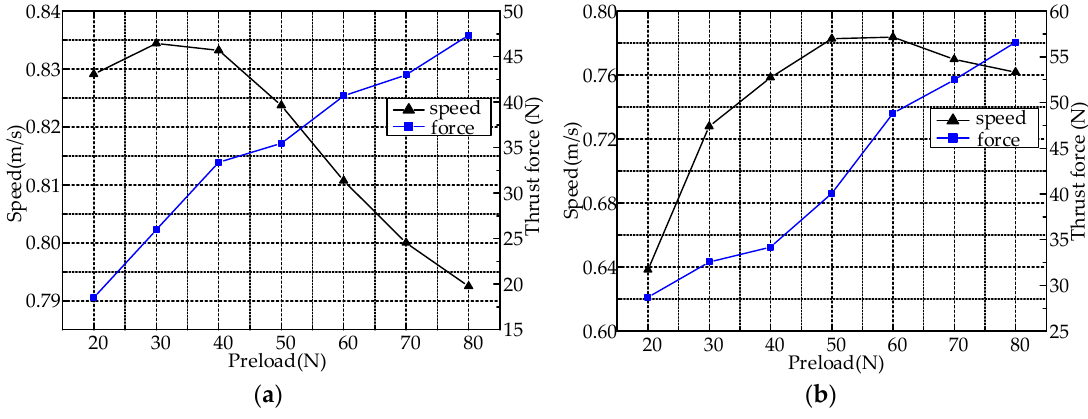
Figure 9. The real image of experimental platform and the speed curve: ( a ) The real image of experimental platform; ( b ) The speed curve of optimal operating frequency. Appl. Sci. 2016 , 6 , 103